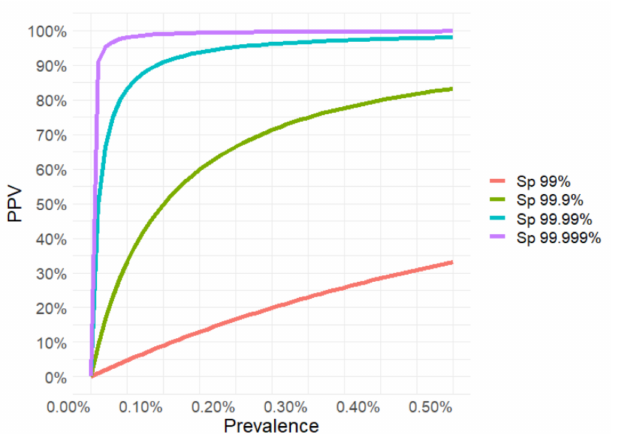
Figure 2. Relationship between the positive predictive value (PPV) of a positive test result and prevalence of a disease. For calculations, test specificities (Sp) from 99% to 99.999% and a test sensitivity (Se) of 99%, when the within-flock prevalence is higher than 10%-were used. The predictive value of the initial positive test result (PPV) at a 0.04% prevalence of